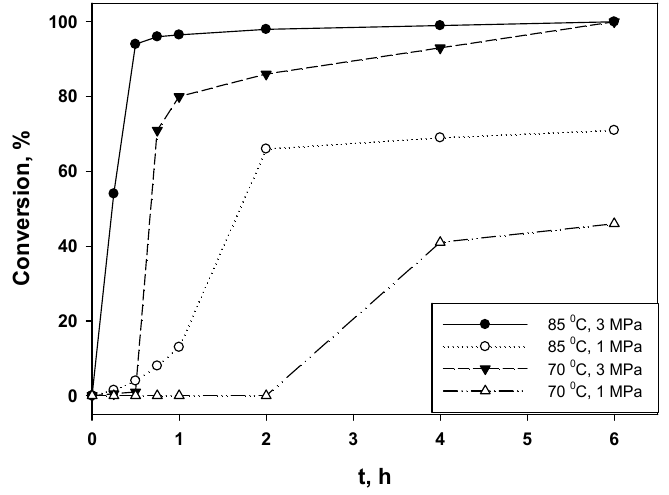
Figure 5. Kinetics of phenol hydrogenation in water in the presence of G3-dendr-SiO 2 -Ru at substrate/Ru = 377. Reaction conditions are: m (PhOH) = V (H 2 O). Catalysts 2017 , 7 , 86